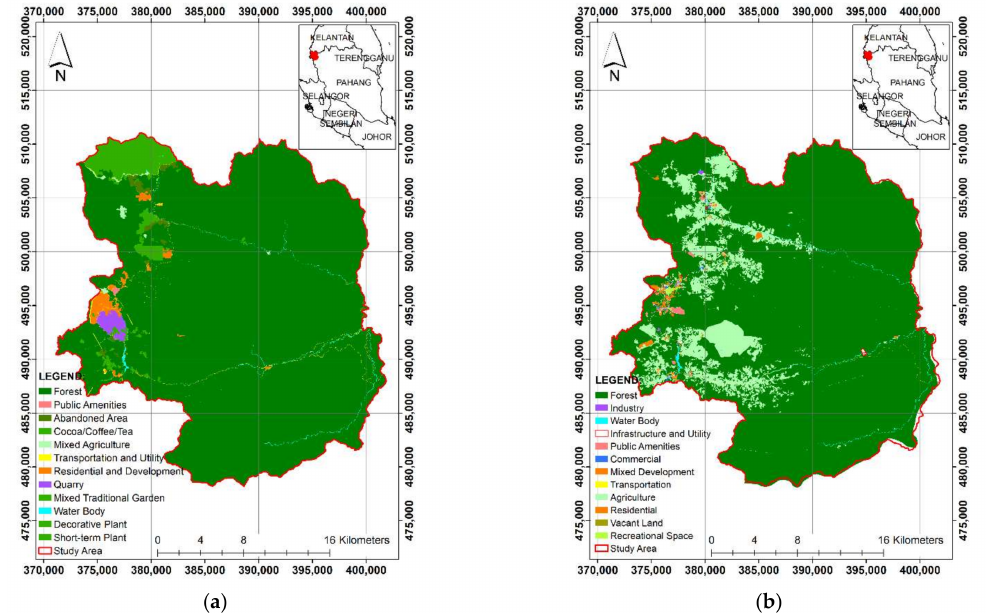
Figure 2. Land use information of the Cameron Highlands provided by ( a ) DOAM (adapted from